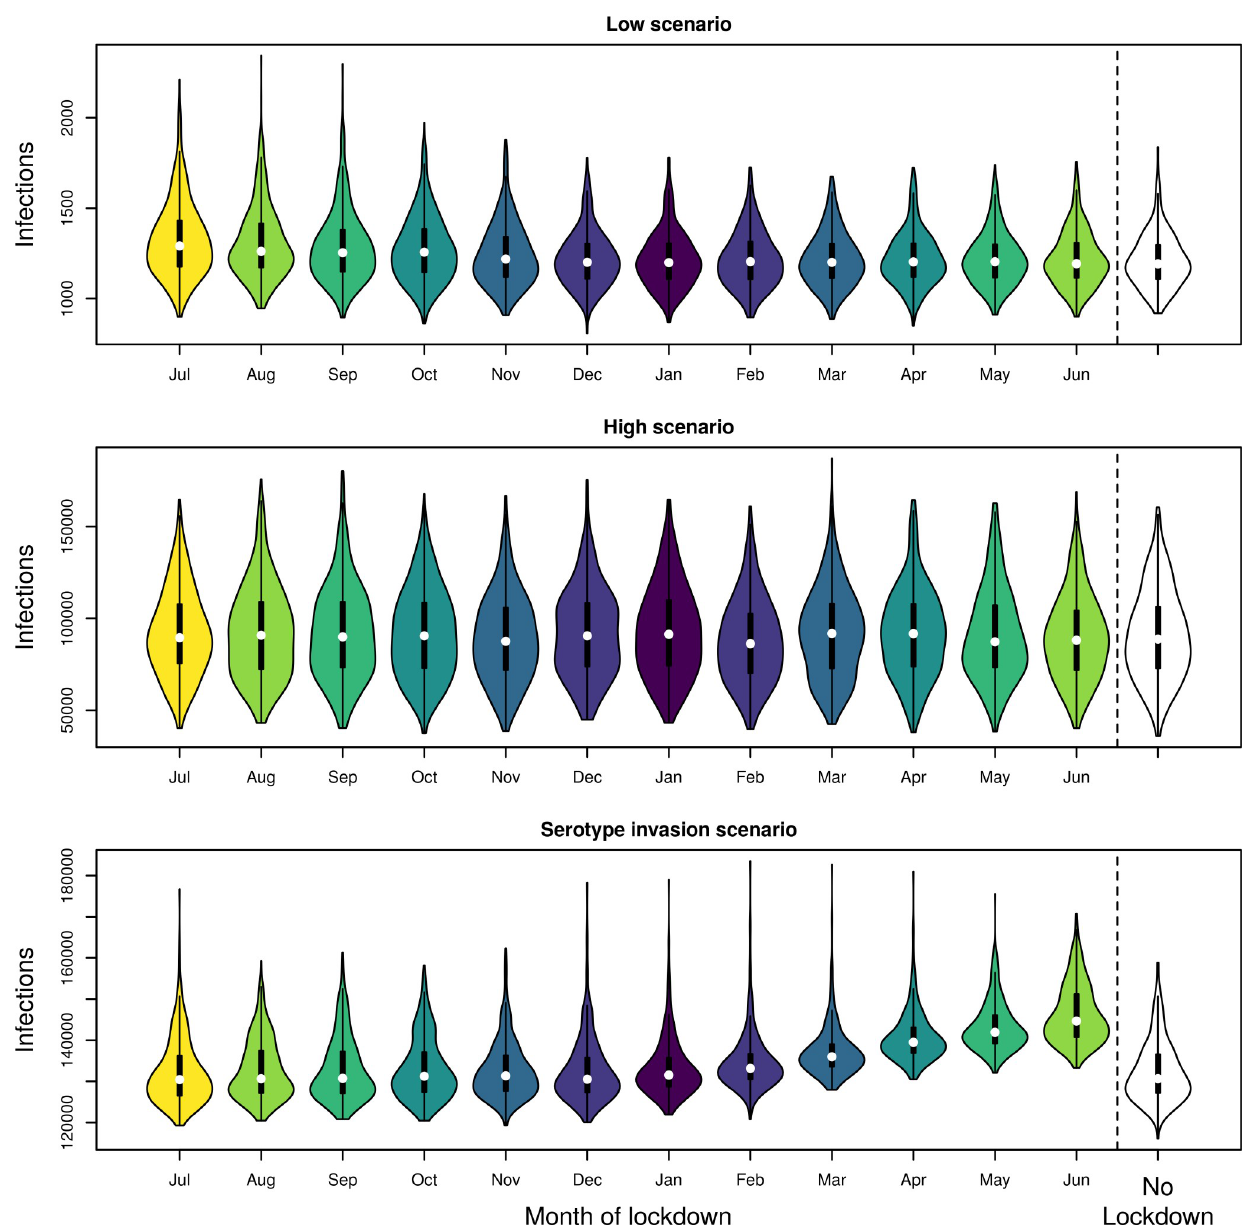
Fig 2. Comparison of cumulative DENV infections when lockdown started on the first of the month in the shown month. Incidence was summed over both the season in which lockdown was initiated and the following season. Different colors denote different months vs no lockdown (no color).